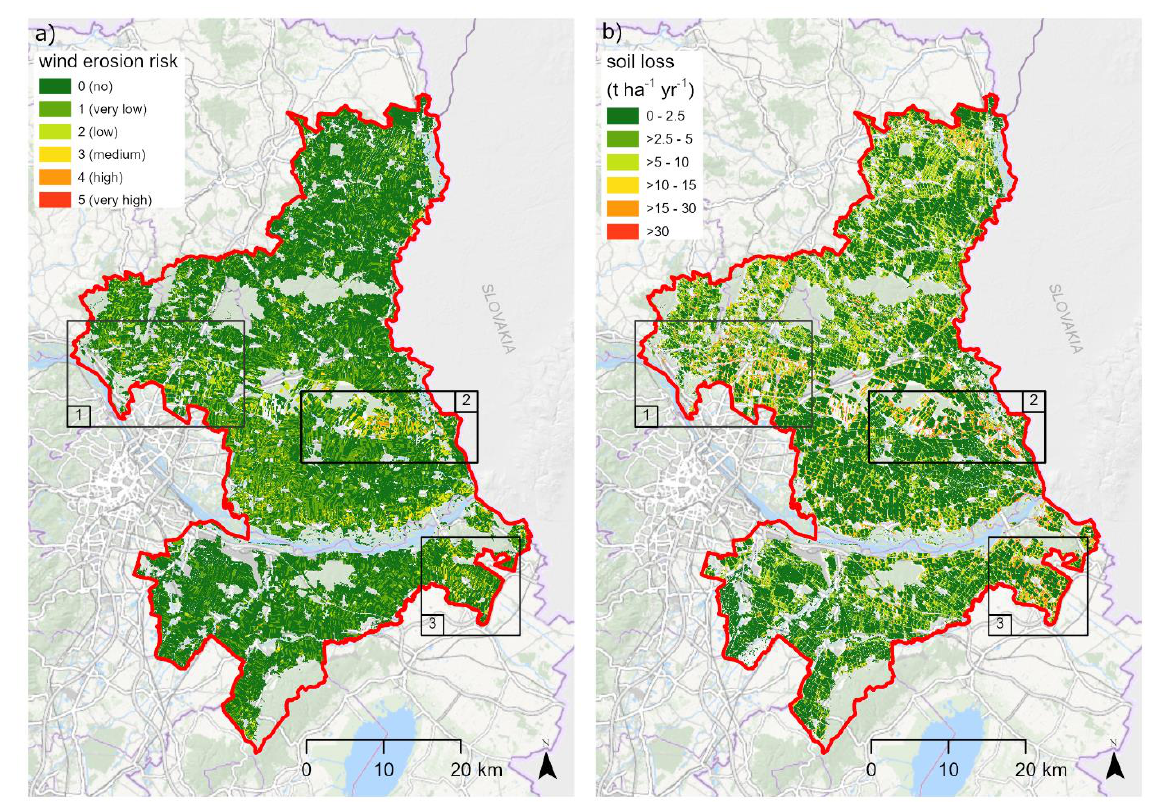
Figure 5. ( a ) Wind erosion risk for the year 2020 based on DIN 19706 and ( b ) average multi-annual soil loss in t ha −1 yr −1 modeled with revised wind erosion equation.